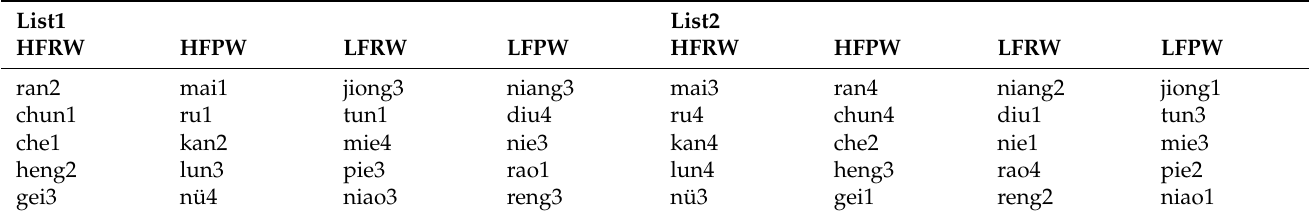
Table A1. The materials of the current experiment for the two lists presented